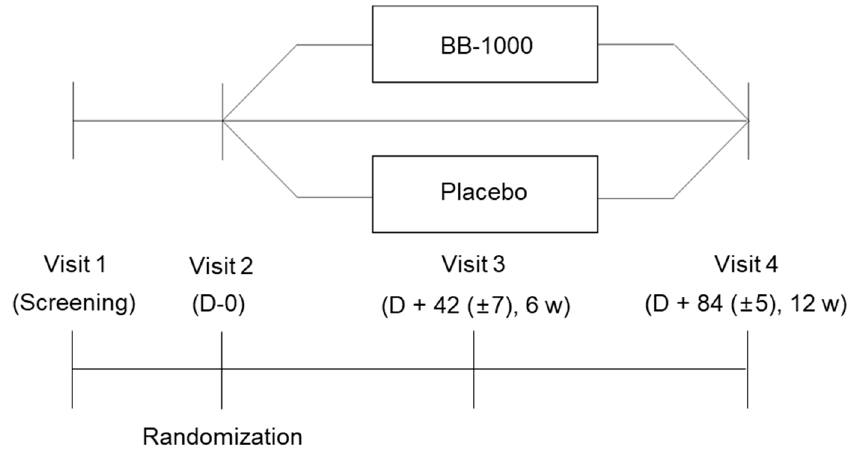
Figure 1. Schematic protocol for clinical